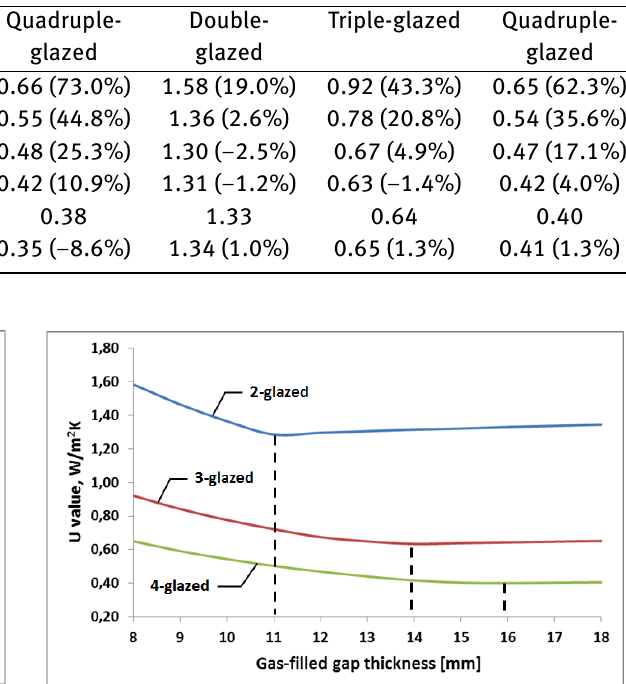
Figure 4: Dependence of thermal transmittance on chamber thick- ness for conditions: t e = − 20 ∘ C, t i = 20 ∘